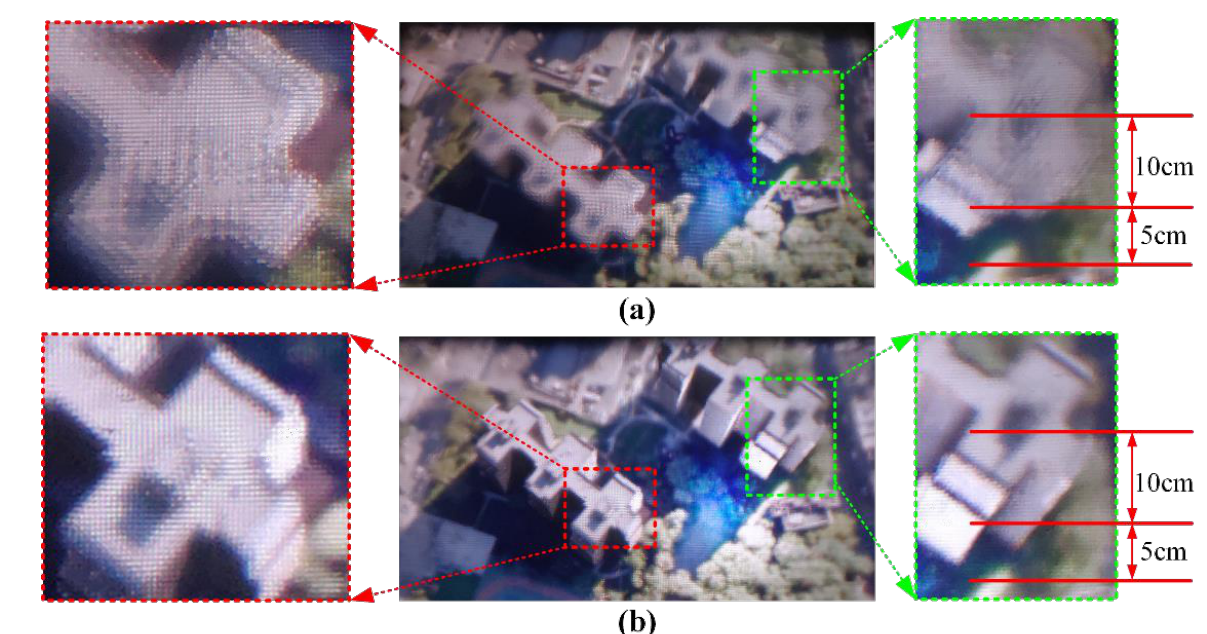
Figure 6. The comparison of reconstructed 3D images. ( a ) Before optimized algorithm; ( b ) after proposed optimized algorithm.